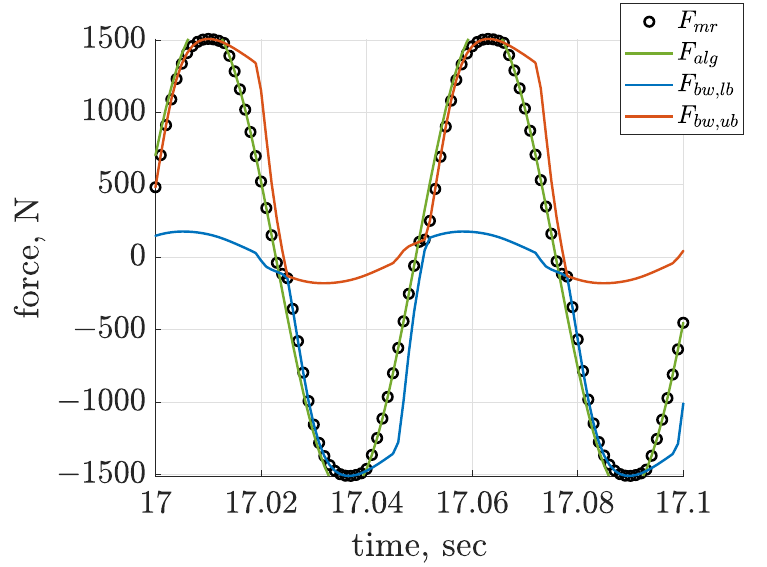
Figure 27. Quality of tracking of the horizontal desired control force F alg , x by the actual MR damper Bouc–Wen F mr , x , accompanied by the lower F bw , lb and upper F bw , ub bounds, presented for the front screen suspension part for the control configuration of ∆ α alg = − 3/4 π rad.